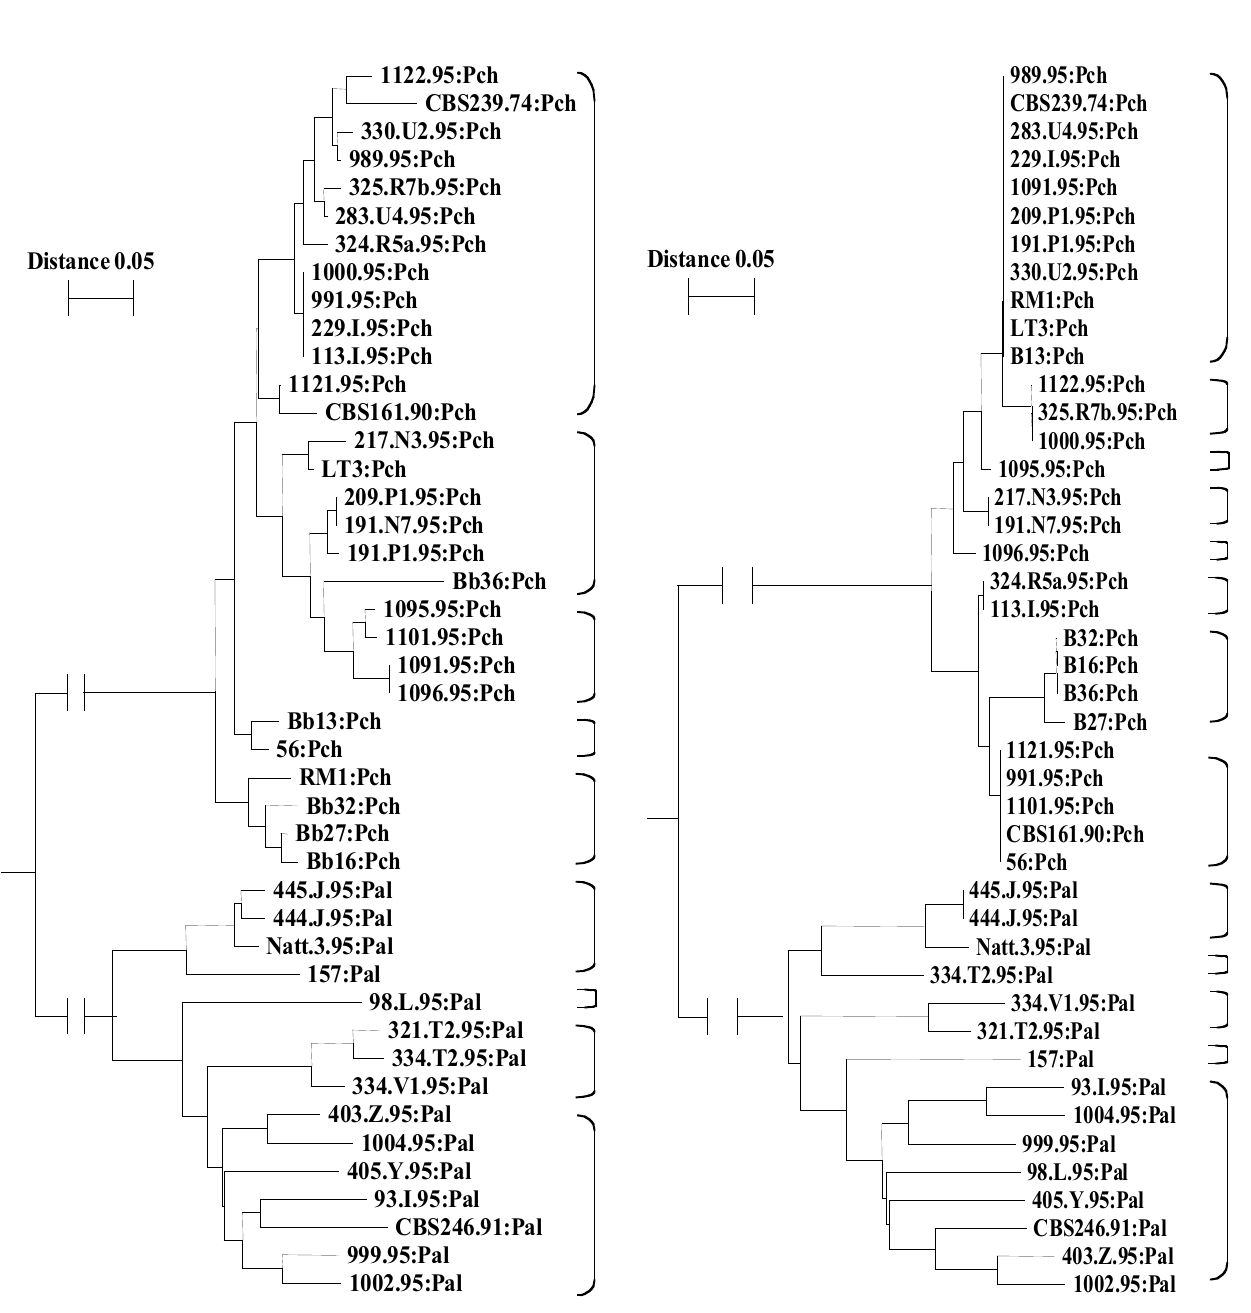
Fig. 1. Dendrogram based on RAPD data showing the relationships among Phaeoacremonium aleophilum and P. chlamydosporum isolates studied. The dendrogram was constructed by TREECON software using the neigh- bor-joining method based on Nei’s genetic distance val- ues.